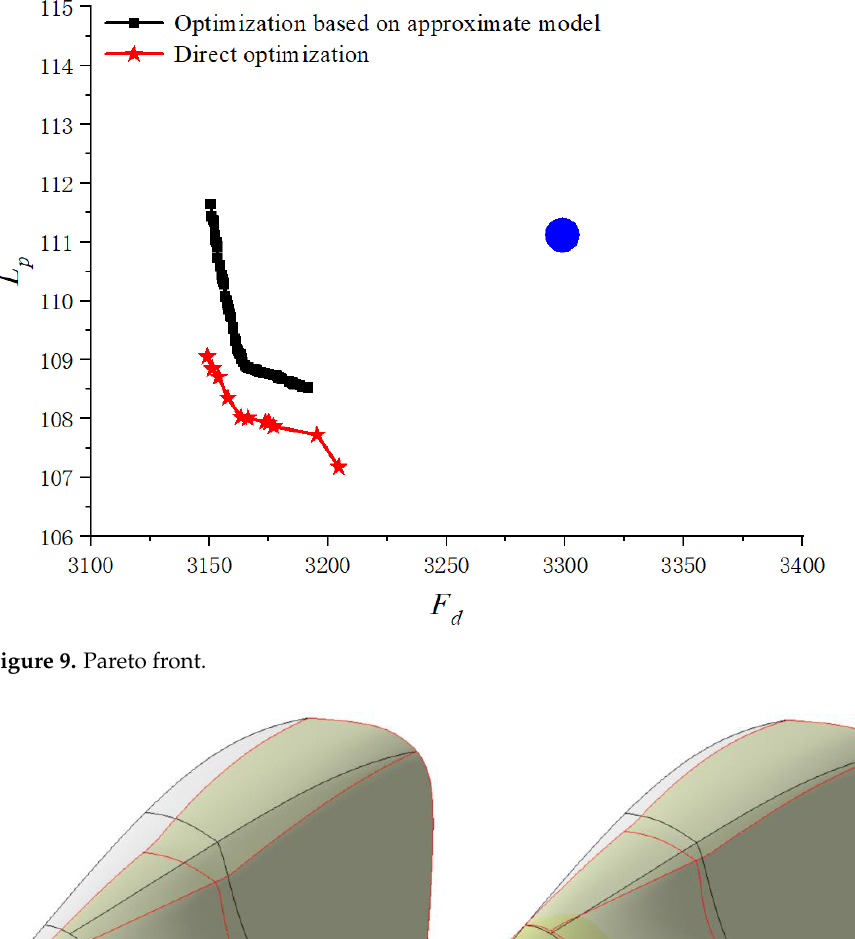
approximate calculation model and direct optimization are 3150.7 N and 3149.1 N, respec-